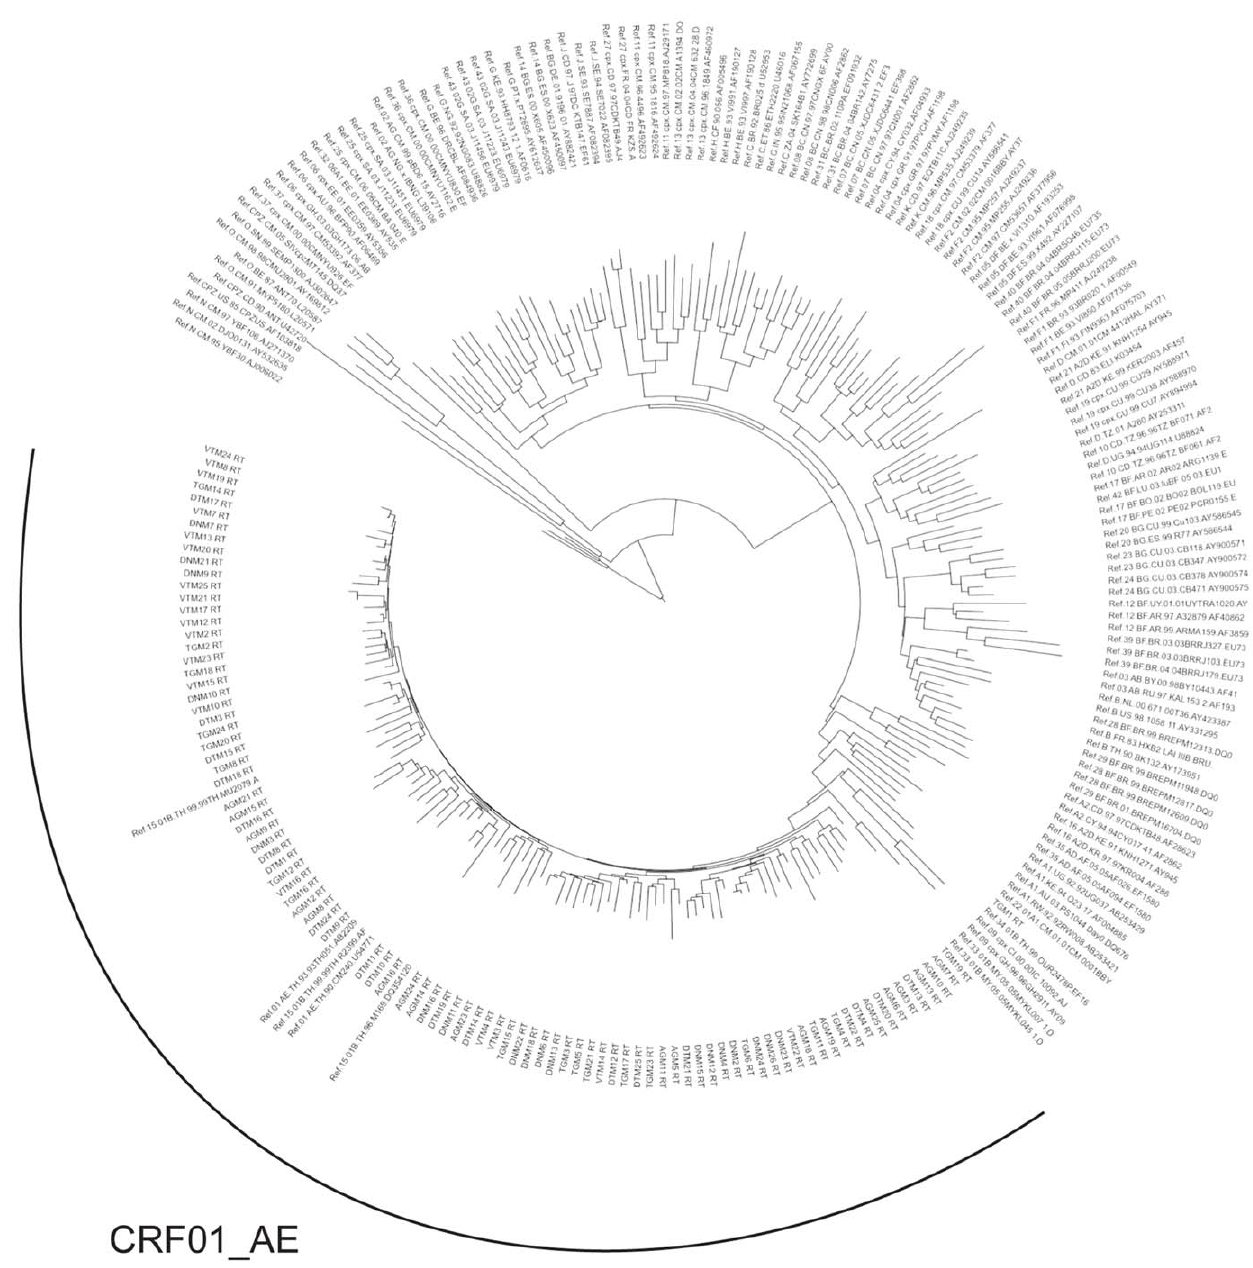
Figure 2. Phylogenic analysis of RT sequences of 125 Vietnamese HIV-1 patients.